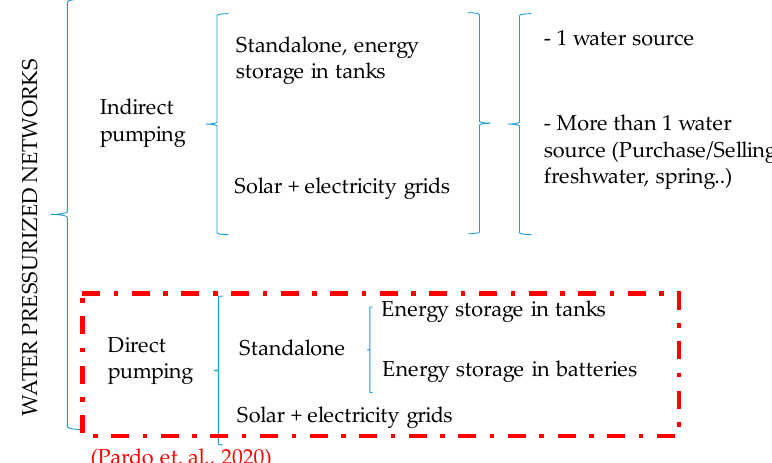
Figure 1. Cases found when planning to convert a water pressurized network into a PV supplied service.